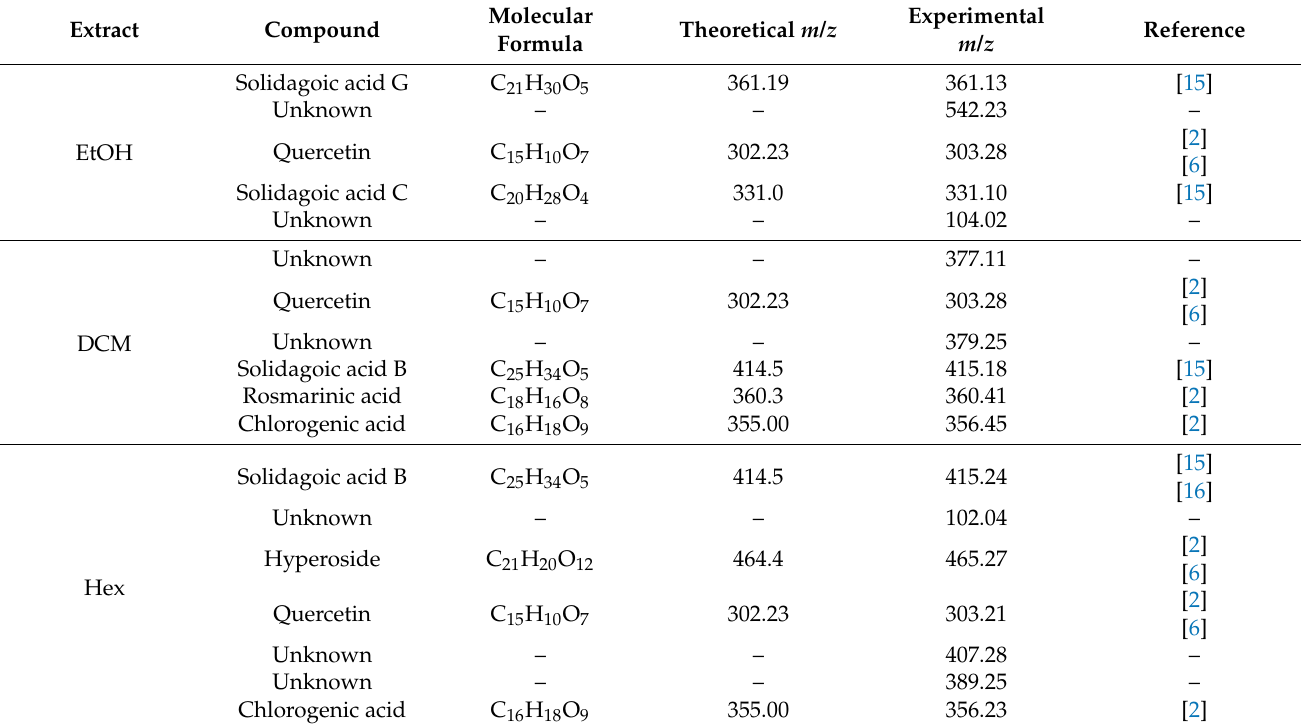
Table 2. Secondary metabolites from organic extracts of S. graminifolia identified by UPLC-MS.